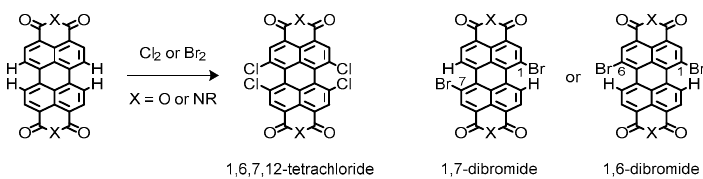
Figure 5. Chemical structures of halogenated perylenes readily available from commercial sources.